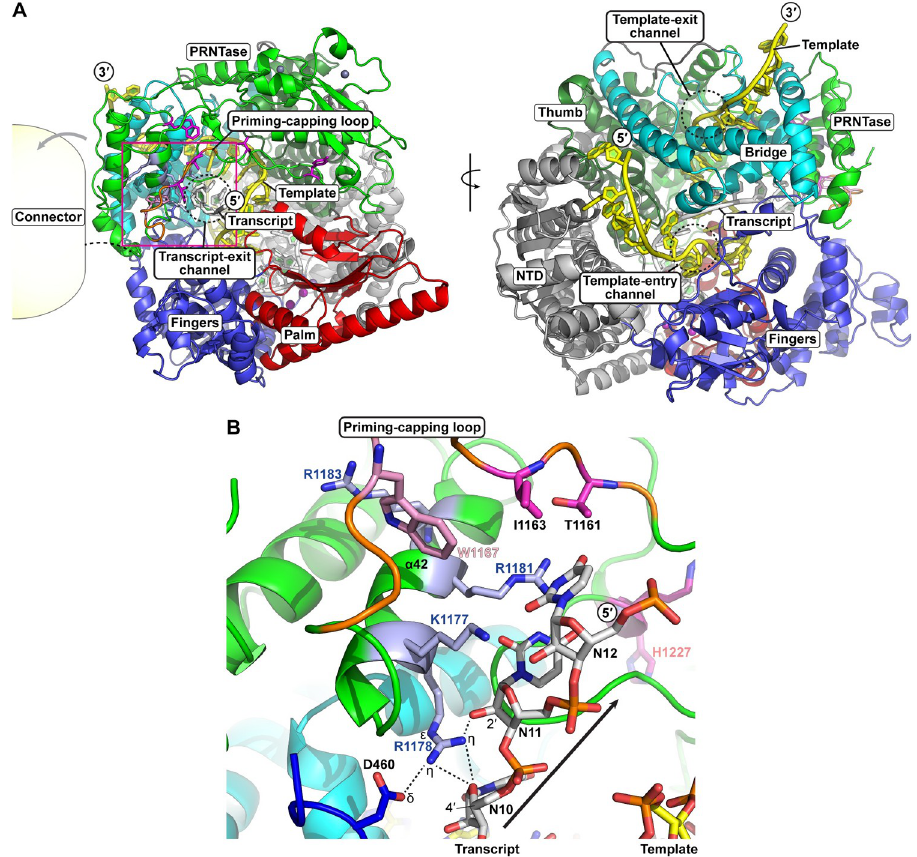
Fig 7. Model of a putative elongation complex of the VSV L protein. ( A ) Two views of a modeled VSV L RdRp core structure (residues 35–1332) in an elongation state (Model Archive id: ma-ecf5b) are shown as cartoon models with the N-terminal, fingers, palm, thumb, bridge, and PRNTase subdomains colored in gray, blue, red, dark green, cyan, and green, respectively. Poly(A) and poly(U) strands of RNA, analogous to the template and emerging RNA strand, are shown in stick models with yellow and off-white shading. The priming-capping loop is shaded with a background of orange. Key amino acid residues required for capping (magenta), the priming residue (pink), and the basic residues (light blue) of helix α 42 are shown in ball and stick representation. Proximity of the connector domain is shown with the yellow bubble to the left. In ( B ), a close-up of residues in the putative exit tunnel for transcription/replication products is shown. The side chain of residue R1178 is within bonding distance of the 2 0 -OH and 4 0 -oxygen of adjacent ribosyl group with the exiting RNA, while also partially bonding to one of the δ -oxygens of residue